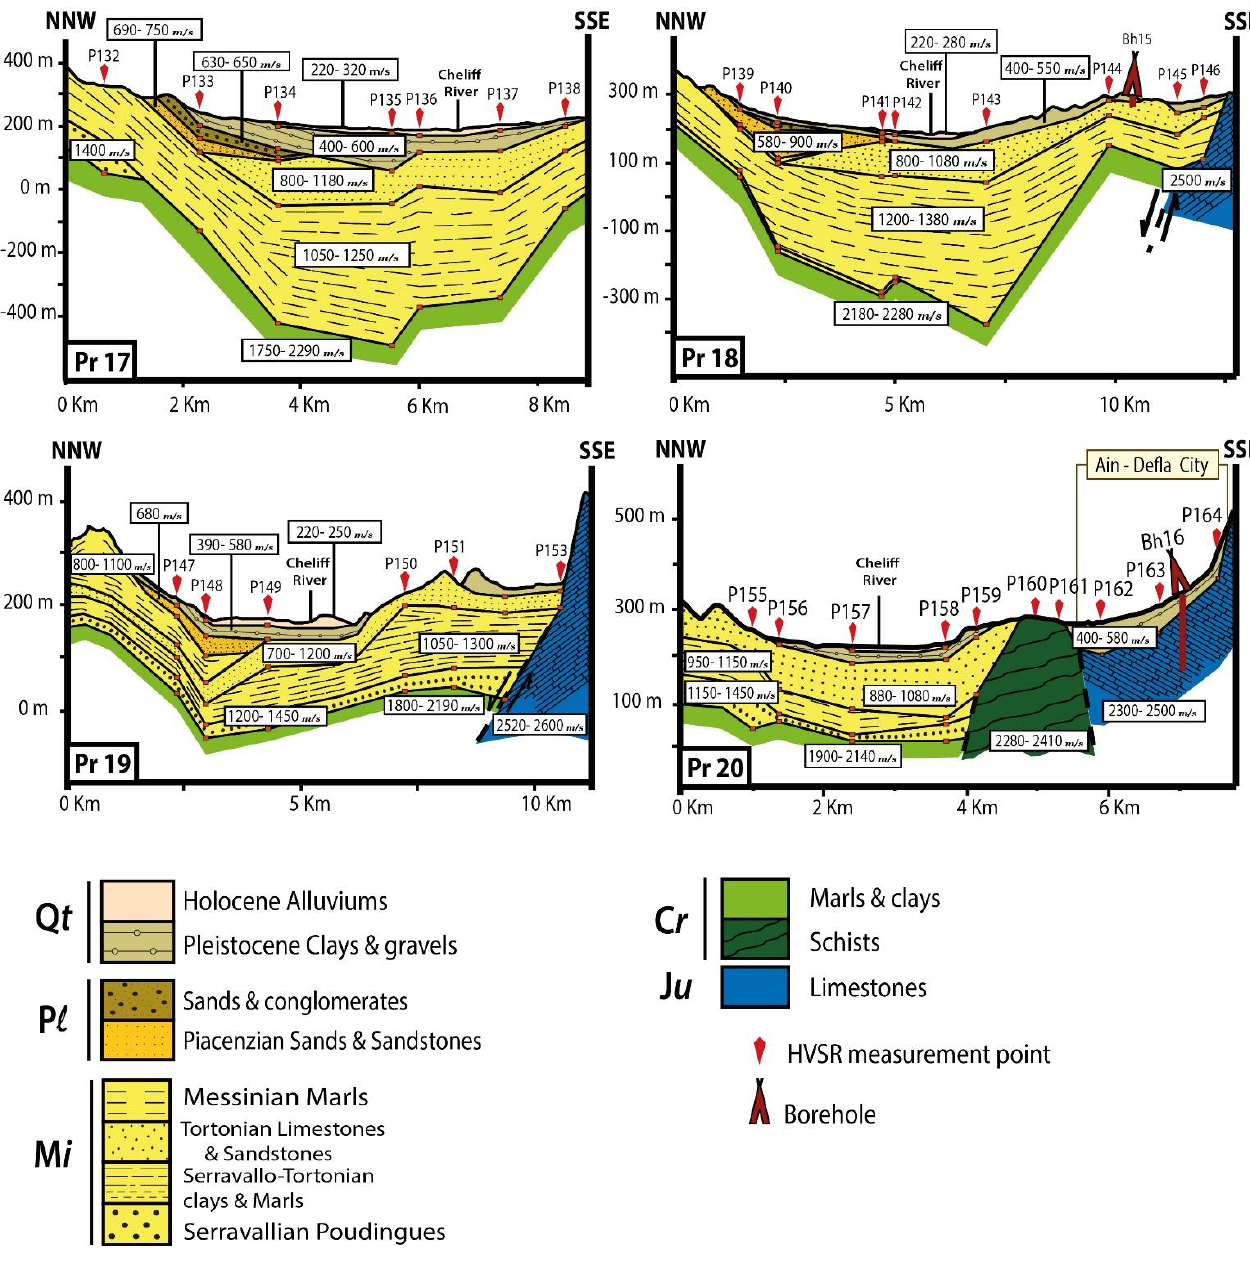
Figure 15. Shear-wave velocity profiles for Zone 3. Qt: Quaternary. Pl: Pliocene. Mi: Miocene. Cr: Cretaceous. Ju: Jurassic. The sedimentary layers become thinner and lie over different types of bedrock. The old formations become more rugged to the south because of the presence of the epimetamorphic Doui Massif (Figure 2). North of the city of Ain-Defla (Profile Pr 20), the Albian clays and marls are separated from the Jurassic limestones by a block of Neocomian schists, which belongs to the Arib Massif that overlooks the Upper-Chelif Plain. The presence of the Neocomian schists marks the transition between the Middle and Upper Chelif Basin. The Vs values for this formation vary between 2280 and 2410 m/s. The average Vp/Vs ratio was calculated from the 164 velocity models. The averaged ratio for the sedimentary column is 1.95. For the bedrock formations, the averaged ra- tio is 1.76. This value is in agreement with the 1.7 found by Bellalem [53] in a seismic tomography